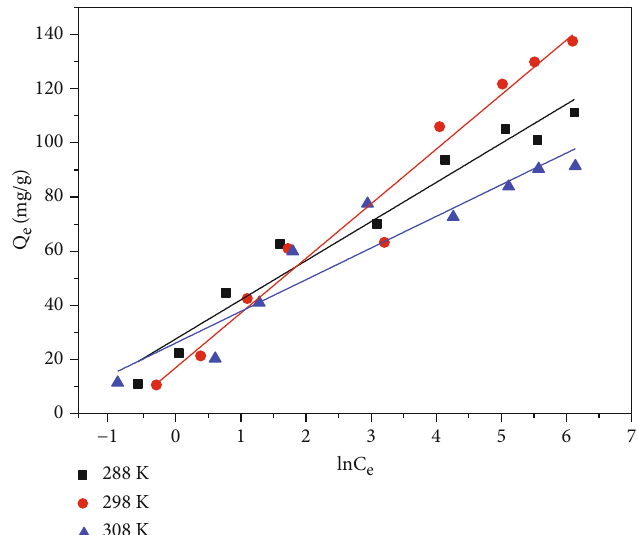
Figure 11: Temkin isotherm for Cr (VI) removal on CSBT.